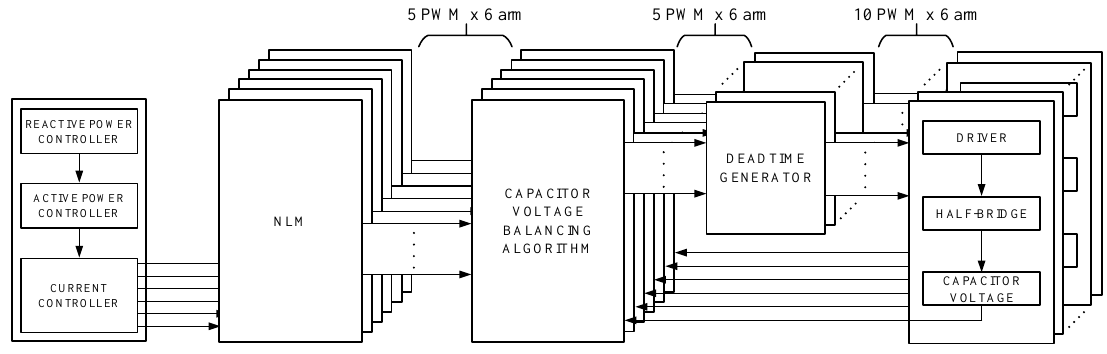
Figure 21. NLM full control diagram.